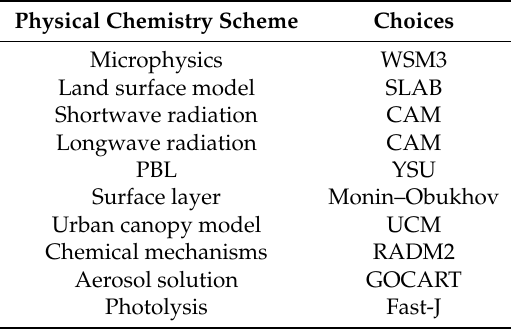
Table 12. Selection of physical and chemical parameterization schemes. (SLAB: 5-layer di ff usion scheme, RADM2: Regional Acid Deposition Mechnism, GOCART: Simple and e ffi cient aerosol solution.